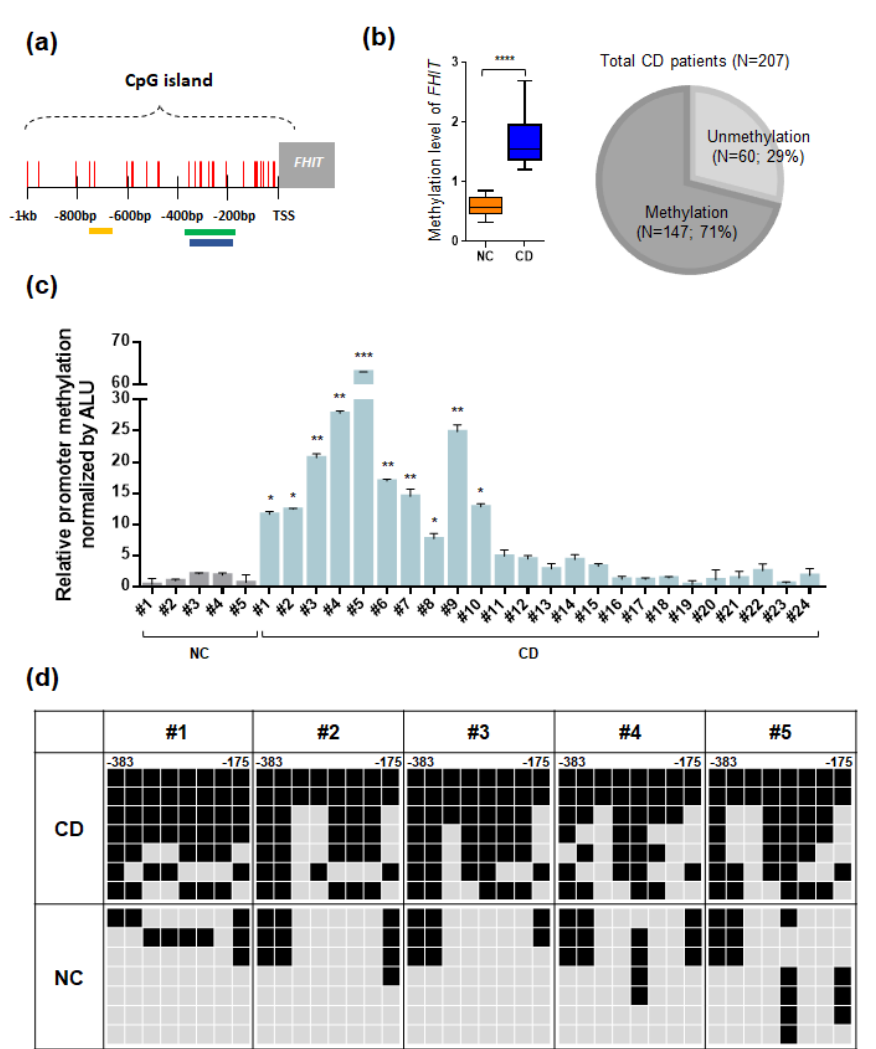
Figure 3. Summary of methylation analyses of the fragile histidine triad ( FHIT ) in CD tissues. ( a ) A schematic representation of the CpG islands in the FHIT gene promoter region. Each CpG site is indicated as a vertical red line, and the yellow, green, and blue boxes indicate the CpG probe site, amplicons for MSP, and bisulfite sequencing, respectively. ( b ) Methylation analysis of FHIT in patients with CD samples. Methylation level of FHIT between CD tissues and normal colon tissues ( n = 12 each) and a Venn diagram indicates the methylation frequency of FHIT in a larger cohort of patients with CD ( n = 207). ( c ) Quantitative MSP of the FHIT gene in selective ulcerative colitis (UC) patient samples and controls. All quantitative methylation levels were normalized by the Alu element. The statistical significance ( p < 0.001) for the FHIT gene is shown between patients with CD samples. ( d ) Bisulfite sequencing analyses of the CpG islands in FHIT gene promoter regions. Bisulfite sequencing analyses were performed with representative patients with CD samples (CD; n = 5) and normal colon tissues (NC; n = 5). The location of CpG sites in the FHIT (upstream region from − 383 to − 175) relative to the transcription start sites (TSSs) of exon 1. Each box represents a CpG dinucleotide. Black boxes represent methylated cytosines and gray boxes represent unmethylated cytosines.